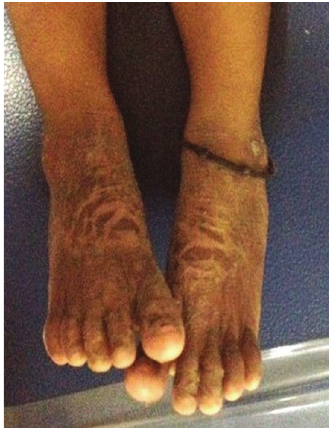
Figure 1: Scaly lesions present in face and hand.